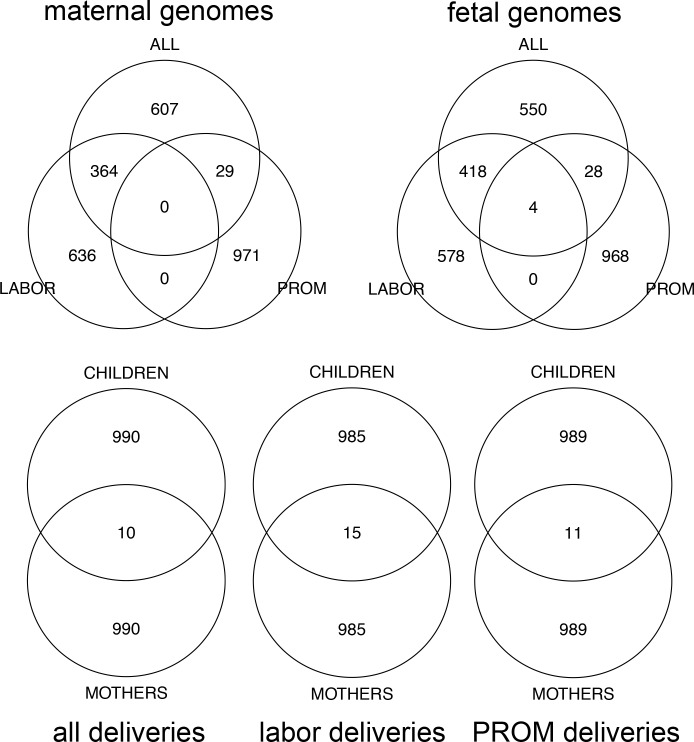
Overlap between top results in six GWAS.The top 1000 SNPs were selected from each GWA analysis. Numbers in the Venn diagrams represent the number of SNPs. Numbers of individuals in each analysis were 1743, 1407, 336 (mothers) and 1109, 884, 225 (children) for all together, labor-initiated and PROM-initiated deliveries respectively.